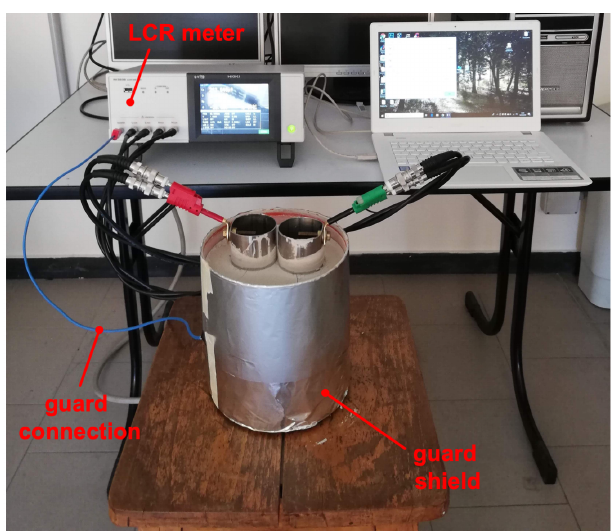
Figure 8. Test setup for the measurement of the capacitance.